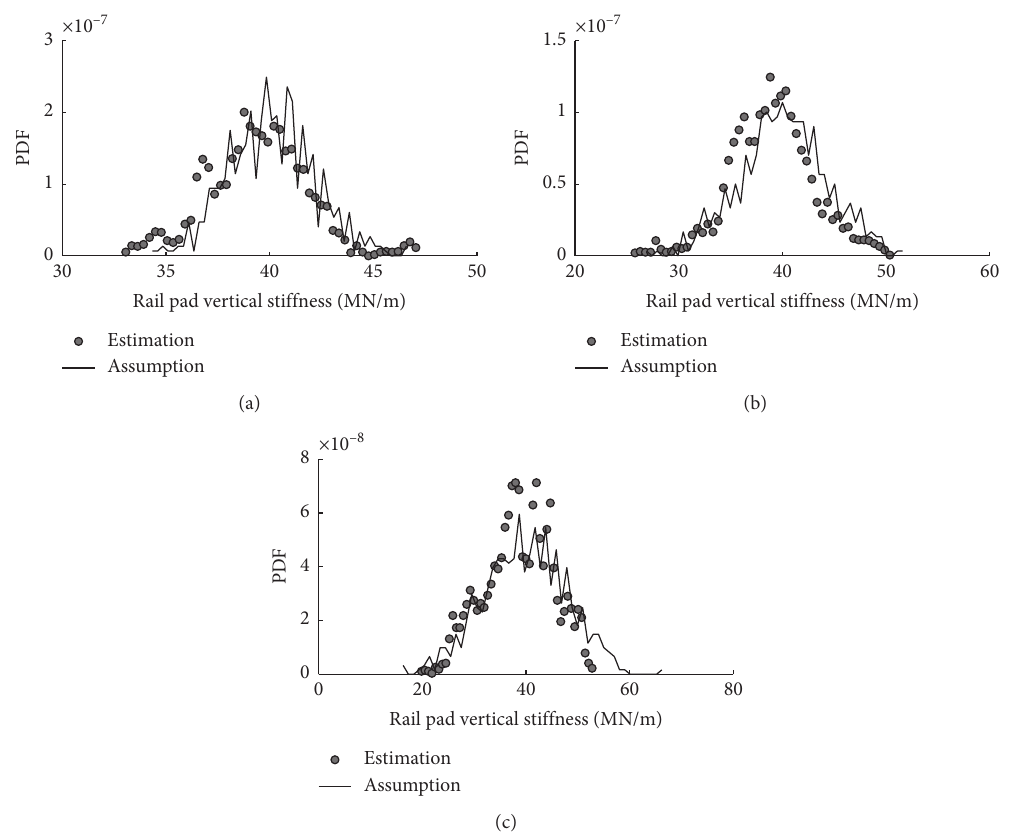
Figure 15: Comparisons between estimation and measurement estimated by the wheel-rail vertical forces. (a) CV � 0.05; (b) CV � 0.10; (c) CV � Figure 13 plots the time-domain responses of rail vertical set of excitations (parametric and irregularity), which has displacement with CV � 0.2, from which one can observe properly covered the responses Z ( t | Ω ) and Z ( t | X ) . that the rail vertical displacement changes significantly against time once with the longitudinal inhomogeneity of vertical stiffness of rail pads, that is, Z ( t | Ω ) versus Z ( t | X ) . ) , is the result of a The response assemblage, that is, Z ( t | M X